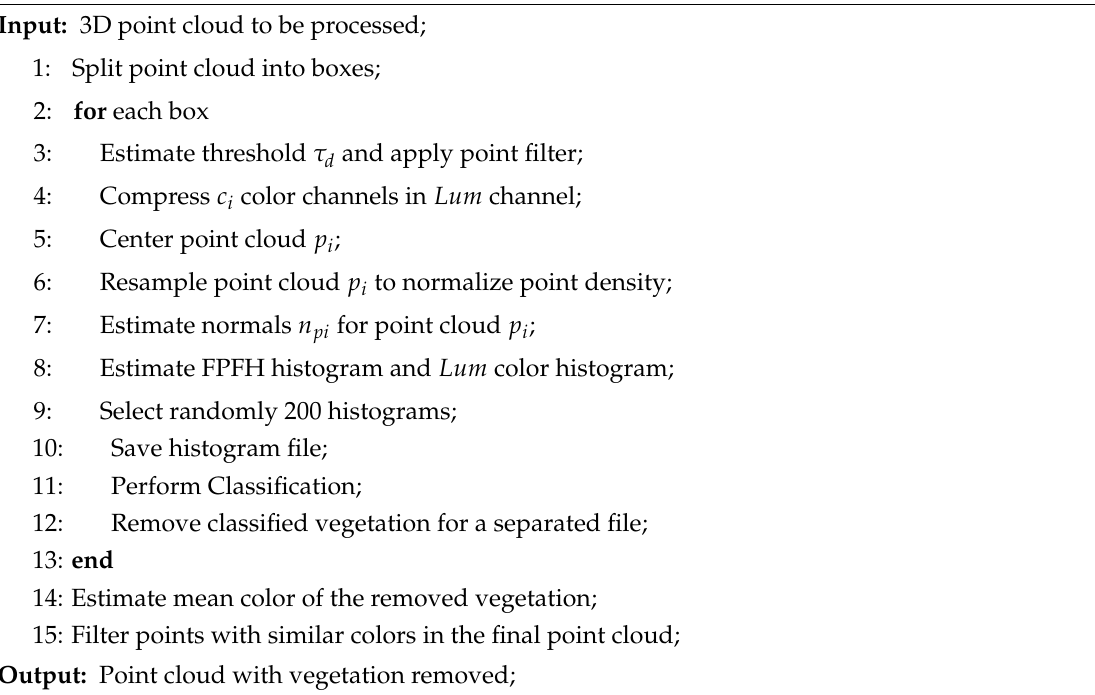
Algorithm 1 Vegetation Extraction Algorithm